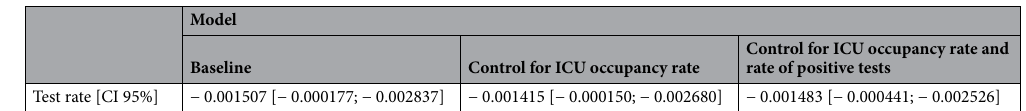
Table 3. Estimation of the effect of SARS-CoV2 testing strategy on the mortality rate using fixed effect models in the contiguous border department-pairs sample, France, March–May 2020. (n = 237). The models analyzed 45 periods, with 12 regions, 69 departments, and 237 department-pairs. Results are calculated in percentage points with 95% confidence intervals (CI 95%). When controlled for ICU occupancy and rate of positive tests, the model using contiguous border department-pairs sample shows an increase of 1 percentage point in the tests/hospitalizations ratio leads to a statistically significant decrease in the case mortality rate of 0.0015 percentage point. CI confidence interval, ICU intensive care